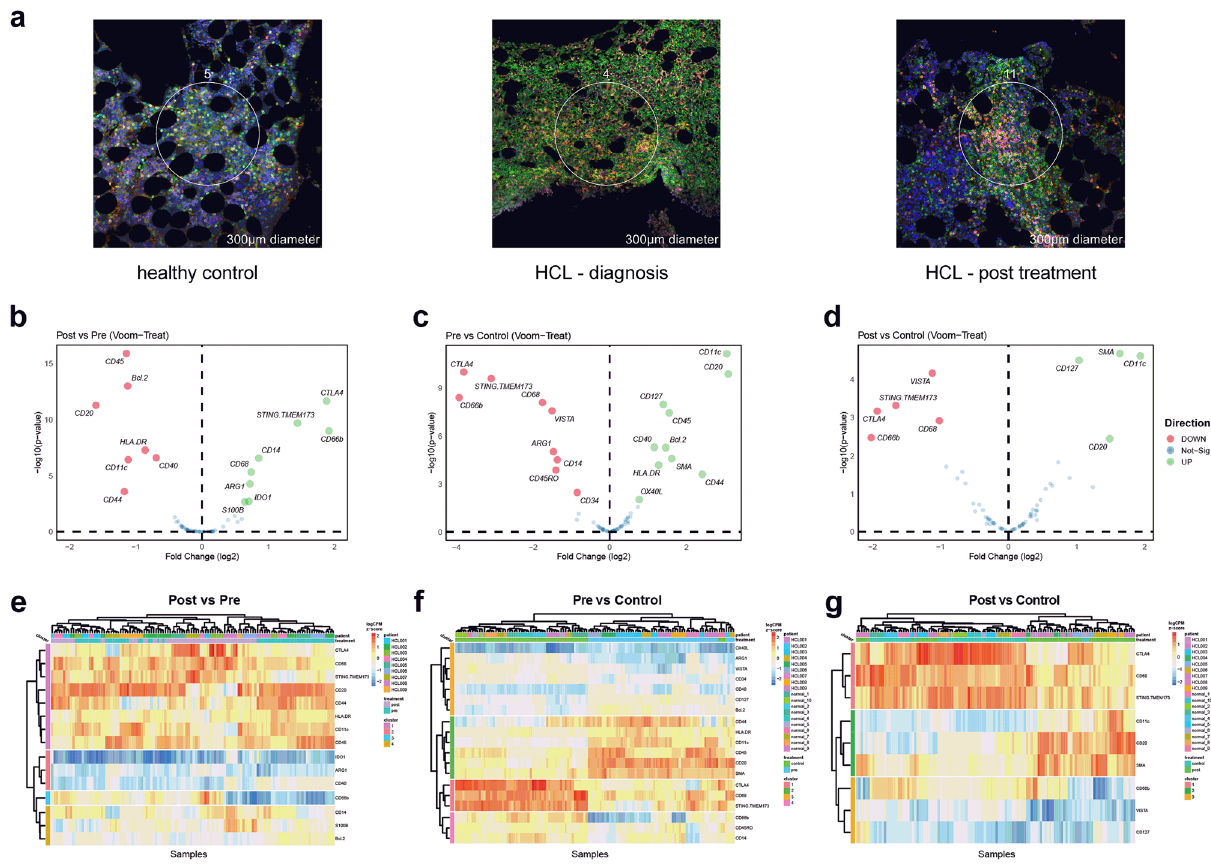
Figure 1. DSP identifies changes in multiple immune markers between pre-CDA, post-CDA and control samples. ( a ) Representative ROIs from each sample type in this study. Red = CD3, Green = CD45, Blue = nuclei, Yellow = dual CD3/CD45. ( b )–( d ) Results of limma-voom-treat multivariate analysis comparing differential expression between pre- versus post-CDA ( b ), pre-CDA versus control ( c ) and post-CDA versus control ( d ). Heatmap of respective samples and differential expression markers for the following comparison: pre- versus post-CDA ( e ), pre-CDA versus control ( f ) and post-CDA versus control ( g ). Z-score normalised logCPM visualised in each heatmap. Heatmaps were generated in R (version 1.0.12) using R package pheatmap. Hierarchical clustering was conducted using the hclust function in the base R statistics